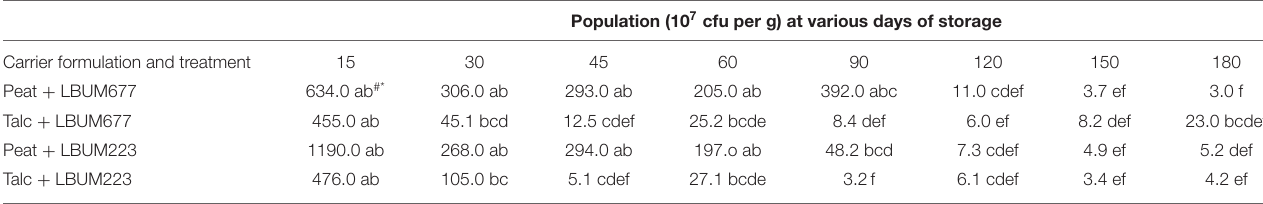
Population (10 7 cfu per g) at various days of storage